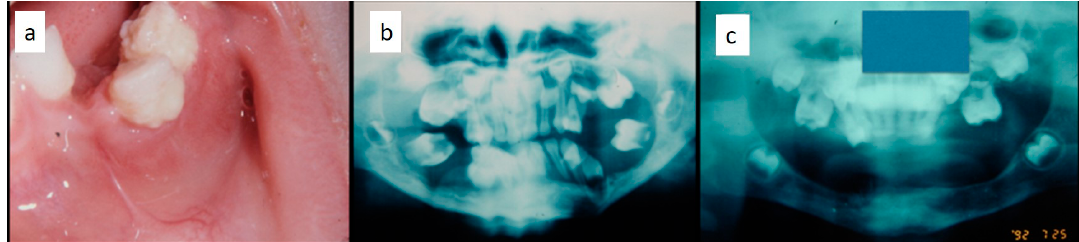
Figure 5. ( a – c ): Diffuse periodontal lesions in the mandible in a 5 year-old female patient causing teeth mobility with pathological fracture and dislocation on the left side ( a , b ); panoramic radiograph after medical and functional treatment ( c ).